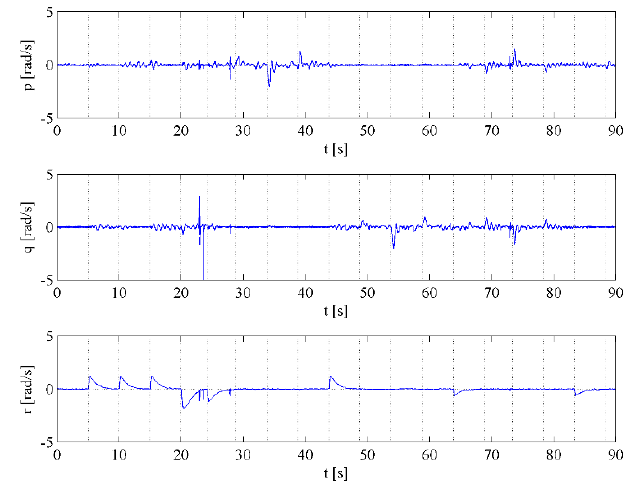
Figure 15. Angular velocity in E B (the body-fixed frame) of the quadrotor when using the LQR (Linear Quadratic Regulator) controller.